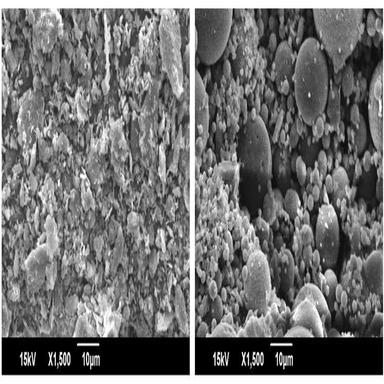
SEM micrographs of (a) WTS and (b) FA particles.